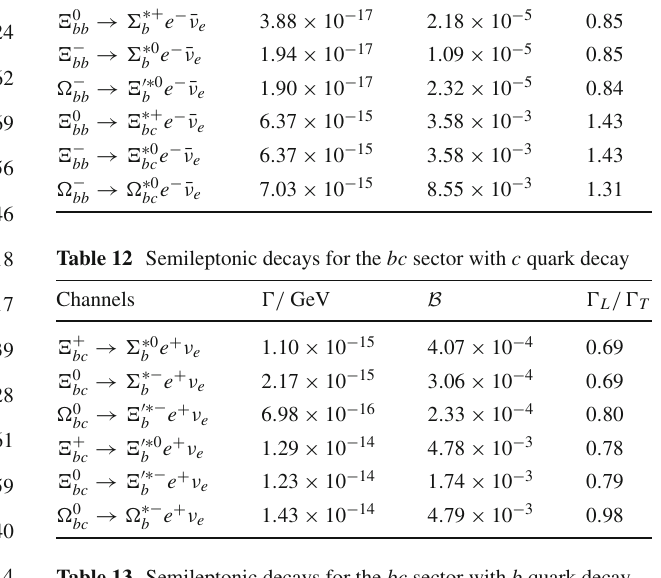
Table 13 Semileptonic decays for the bc sector with b quark decay